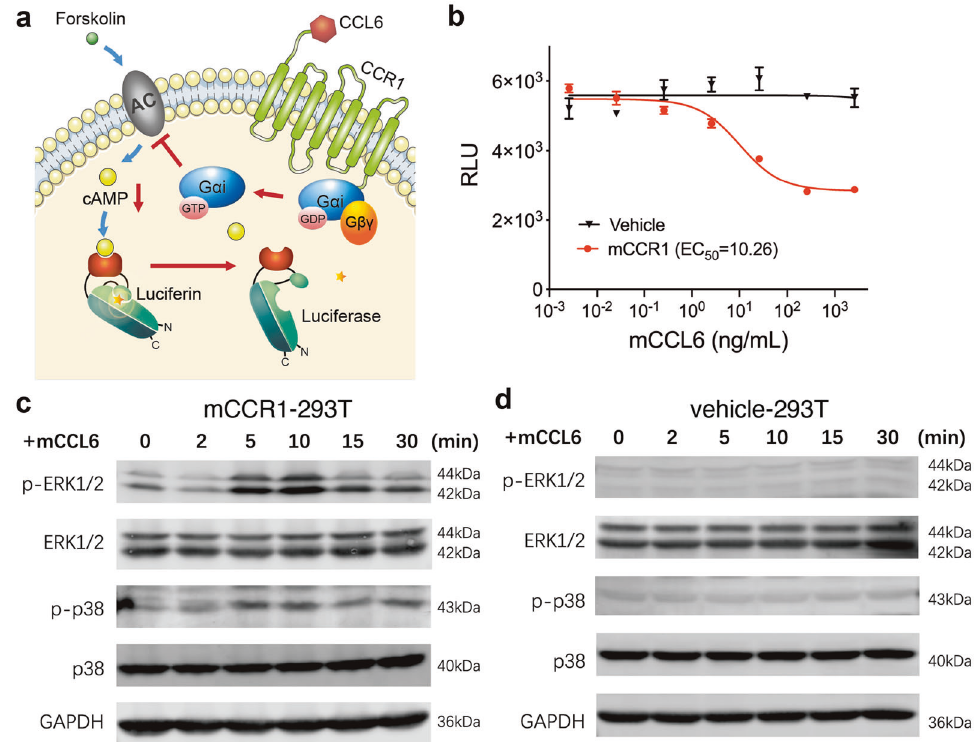
Fig. 5 mCCL6 directly activates CCR1 and downstream signaling. a Schematic illustration of GloSensor assay in CCR1. Forskolin arti fi cially elevated cAMP levels by activating adenylyl cyclase (AC) whereas CCR1 agonist inhibits AC activity. b Dose-response curves of the intracellular cAMP level measured by GloSensor assay. GloSensor-HEK293T cells transfected with vehicle or mCCR1 were treated with forskolin (1 μ M) and indicated concentrations of mCCL6. The reduction of cAMP was recorded after 30 min. Data represent mean ± SEM of three technical replicates (error bars smaller than symbols are not shown). Median effective concentration (EC50) was calculated by nonlinear regression (three parameters). c , d Representative blots of p-ERK1/2, ERK1/2, p-p38, p38 and GAPDH (loading control) assessed by Western blot of protein extracts from mCCR1-293T ( c ) or vehicle-293T ( d ) cells cultured with 200 ng/ml